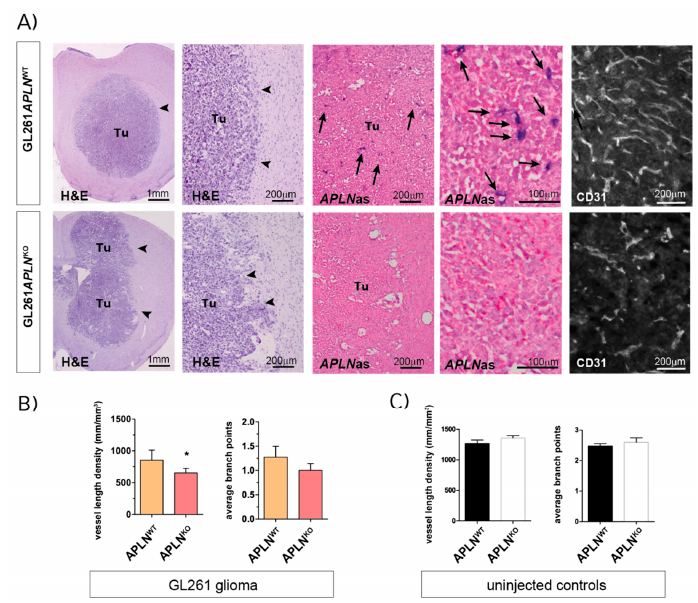
Figure 2. Endothelial APLN expression controls formation of a complex GBM vasculature. Orthotopic GL261 implants in APLN WT or APLN KO mice 21 days post-implantation (dpi). ( A ) The panels on the left indicate the tumor (tumor boarder highlighted by arrowheads) in the right brain hemisphere in overview and close up view on Hematoxylin & Eosin (H&E) sections. The in situ hybridization panels in the middle show the loss-of vascular APLN expression (arrows) in the tumor in overview and close up view when comparing APLN WT to APLN KO mice. The CD31-immunostaining shown in the panel on the right illustrates the reduced vessel density in APLN KO mice. ( B ) Vessel length density (VLD) was assessed on CD31 immunofluorescent brain slides and demonstrated a significant decrease in APLN KO mice. In addition, vascular complexity measured by the average branch points (ABP) was reduced in APLN KO as compared to APLN WT . ( C ) In the healthy brain, VLD and ABP do not differ in APLN KO compared to APLN WT mice. Data of n = 9 APLN WT vs. 6 APLN KO mice are reported as mean +/- SEM; statistical significance (students test) is indicated * p < 0.05.